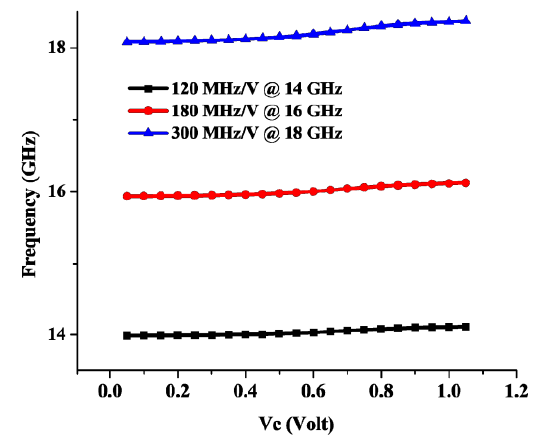
Figure 10. Continuous tuning of the VCO (KVCO).